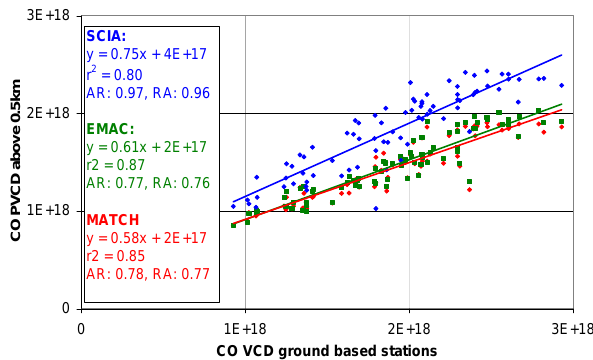
Fig. 7. Correlation analysis of seasonal averages of the CO PVCDs >0.5km vs. total CO VCDs from ground based FTIR stations. Besides SCIAMACHY measurements also the coincident results from both atmospheric models are shown. In addition to the results of the linear regression, also the ratio of the averages (RA) and the average of all ratios (AR) for all data pairs of the considered data sets are shown.